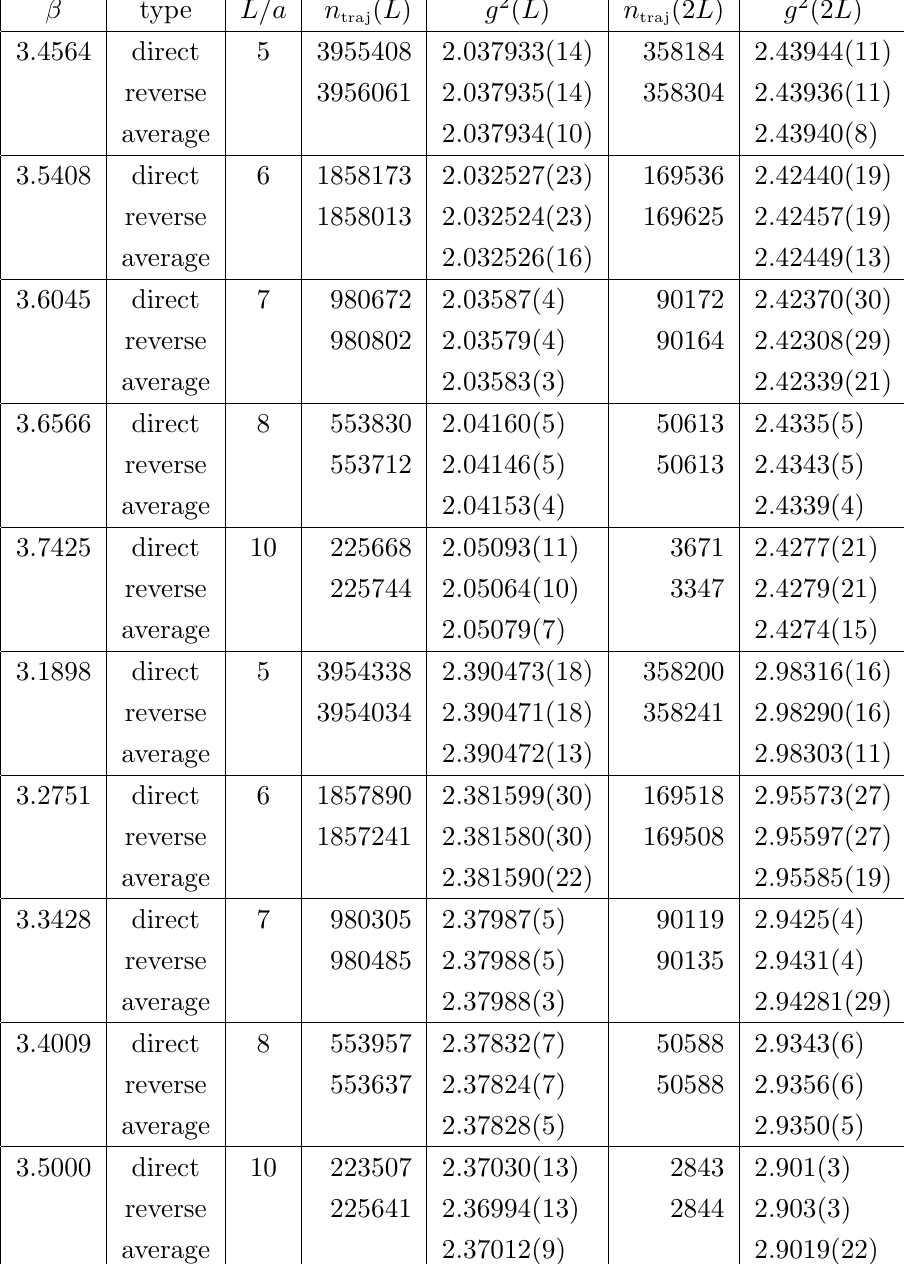
Table 2 . Results for g 2 from the average of direct and reverse transformations with (cid:1) (cid:17) = 0 : 0001 and n = 1000 in SU(2) Yang-Mills qq